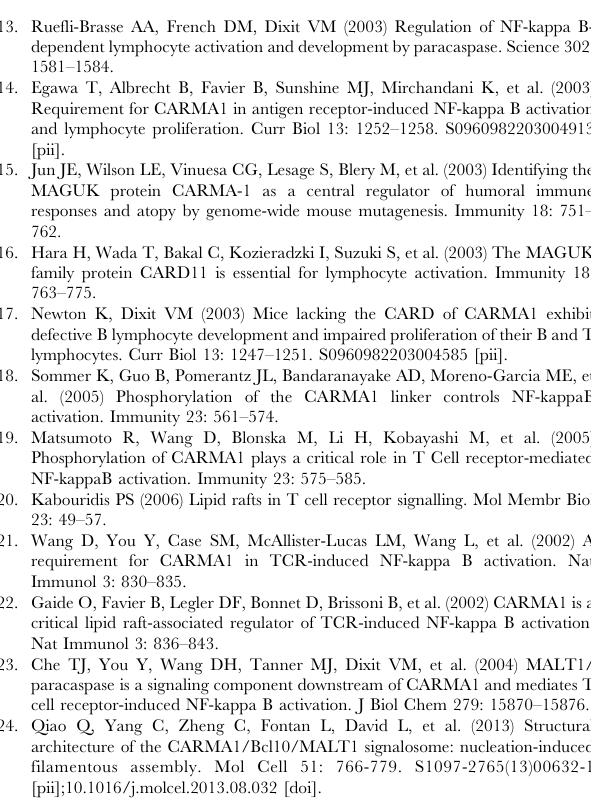
Figure S5 MALT1 auto-proteolysis is not required for initial I k B a phosphorylation and NF- k B nuclear translo- Figure S6 TALEN-mediated knock-out of endogenous MALT1. Jurkat T cells and Jurkat T cells with ectopic expression of MALT1-R149A and MALT1-C464A were electroporated with TALEN pairs targeting a BfaI at the intron1-exon2 boundary of MALT1. Position and size of the introduced deletions in the different generated cell lines are indicated. A single nucleotide polymorphism located 489 bp upstream of exon 2 of MALT1 was